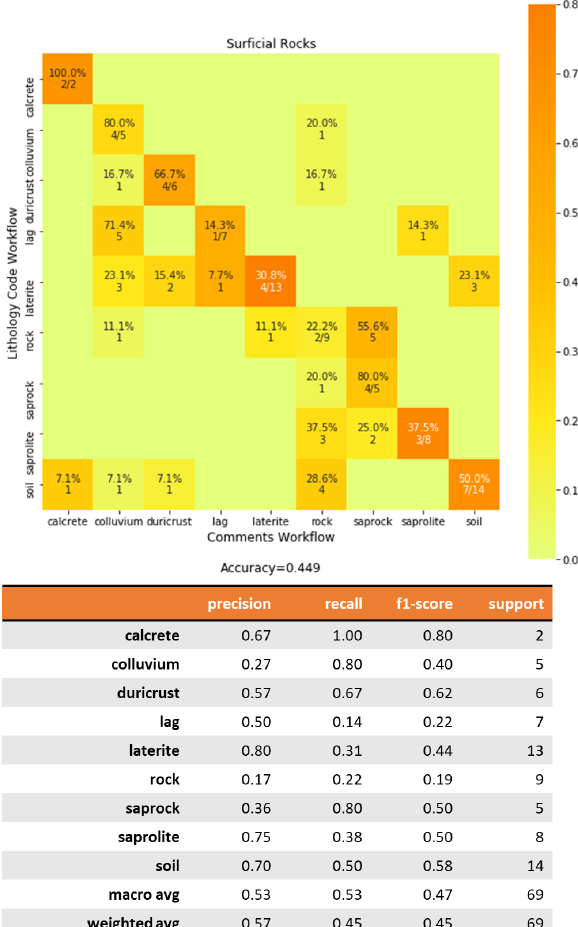
Figure 11. Confusion matrix for surficial rocks comparing the fuzzy string matching results from the Lithology Code workflow (verti- cal axis) and Comments workflow (horizontal axis). The heatmap shows the values normalized to the support size to address the im- balance between classes. The values shown in the cells indicate the number of samples classified for the class. Empty cells indicate zero